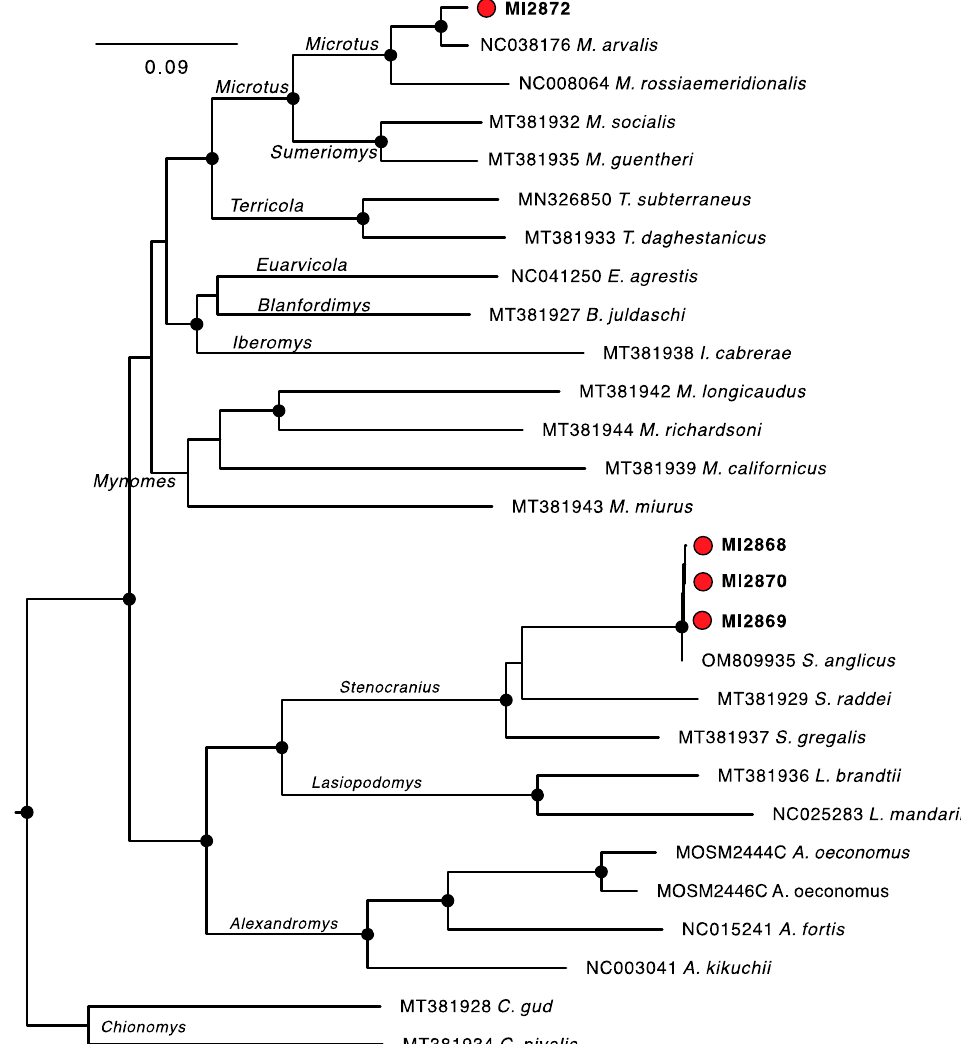
Figure 2. Maximum Likelihood phylogeny of Arvicolinae rodents based on 3 kb fragment of mtDNA. Black circles at nodes indicate ultrafast bootstrap support higher than 90. Tree is rooted with the sequence of Arvicola amphibius (not shown). Red circles denote samples analyzed in this study. Generic names are given above the branches and follow the nomenclature of Abramson et al. [33] and Kryštufek and Shenbrot